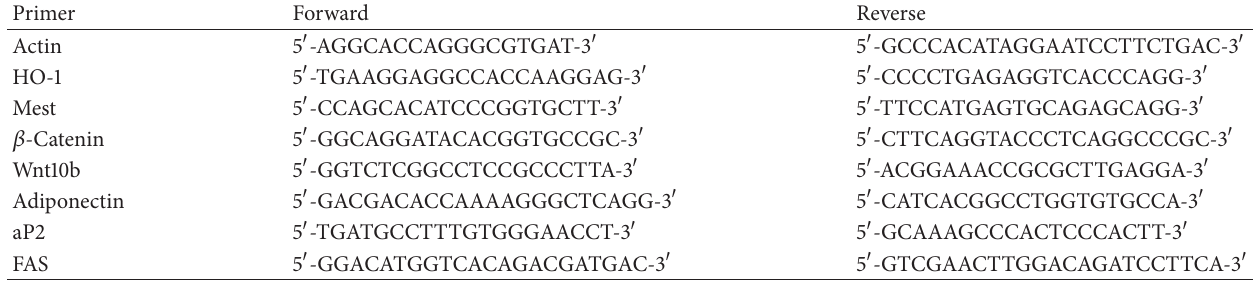
Table 1: The sequence of primers used for real-time PCR.